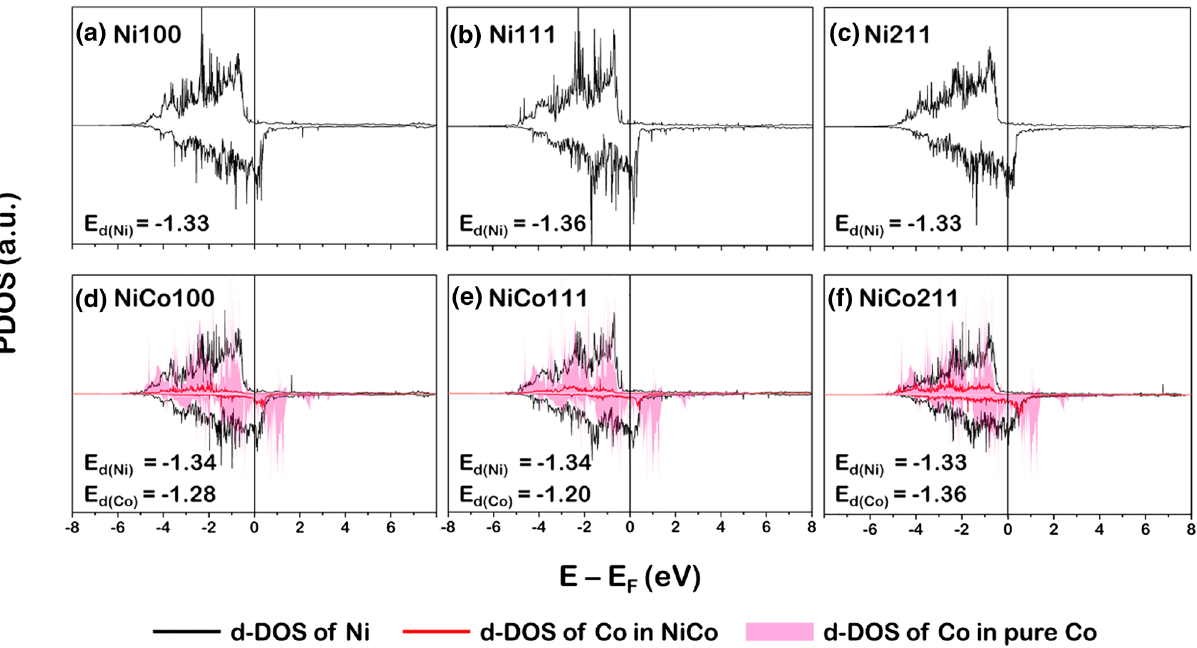
Figure 3. The d-state PDOS of the Ni for ( a ) Ni100, ( b ) Ni111, ( c ) Ni211, and Ni and Co for ( d ) NiCo100, ( e ) NiCo111, and ( f ) NiCo211